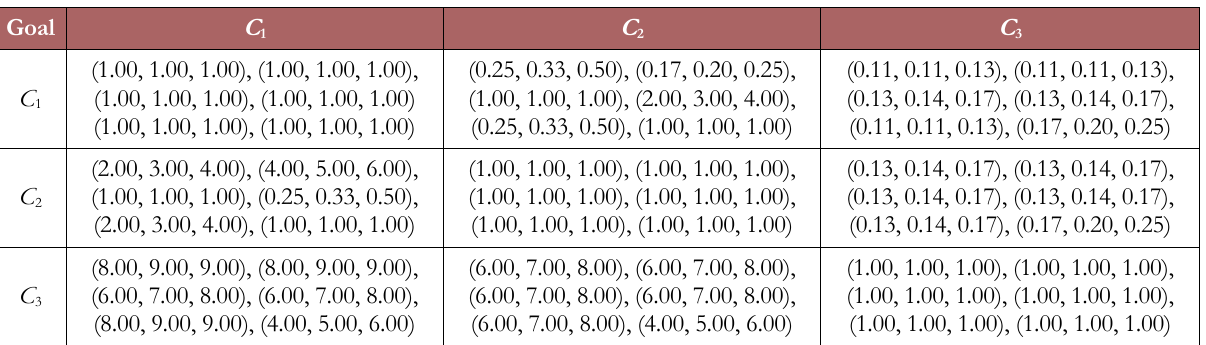
Table 2. The comparison matrix of criteria with respect to goal by the six experts